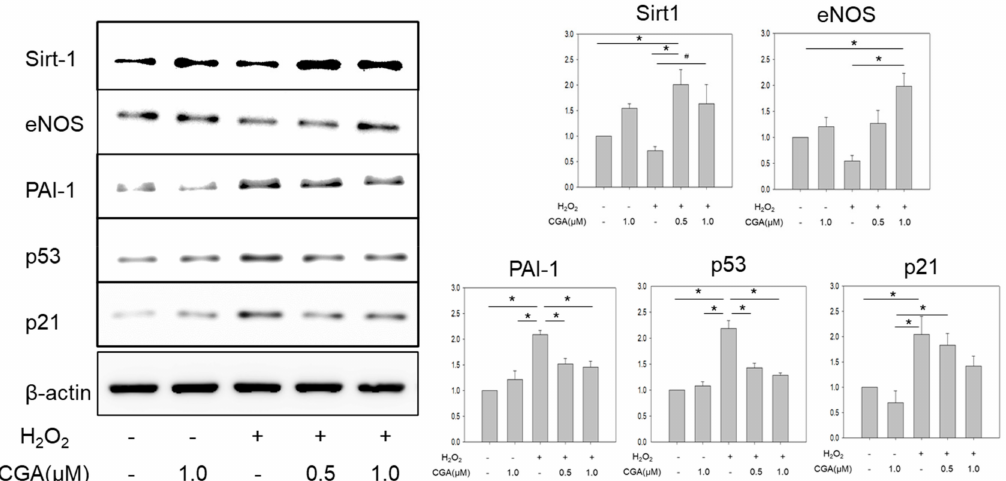
Figure 3. E ff ects of CGA on the senescence-related molecules. Protein expression of Sirt1, eNOS, PAI-1, p53, and p21, Quantitative analyses of the results. * p < 0.05 , # p = 0.0618 , ( n = 6). Values represent the means ± SE of six